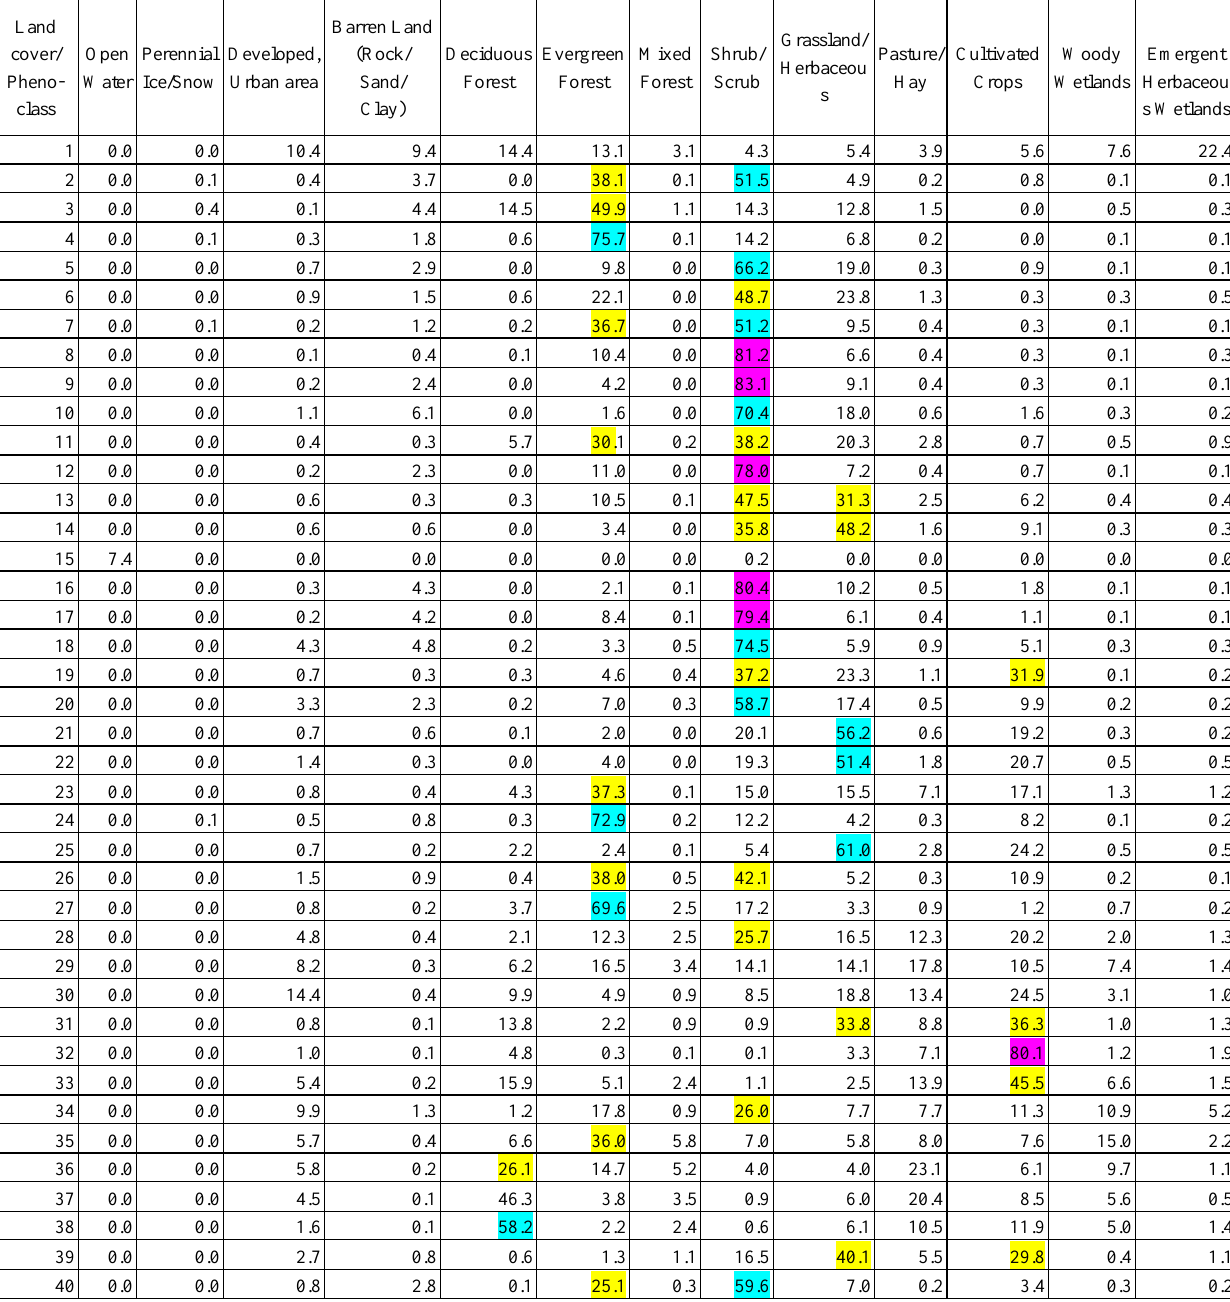
Table 1. Each pheno-class represents a range of different land cover types, which are expressed as a percentage of each coinciding land cover area over the total pheno- class area. Percentage ranges 26–50%, 51–75%, and 76–100% are highlighted in yellow, aqua, and pink,